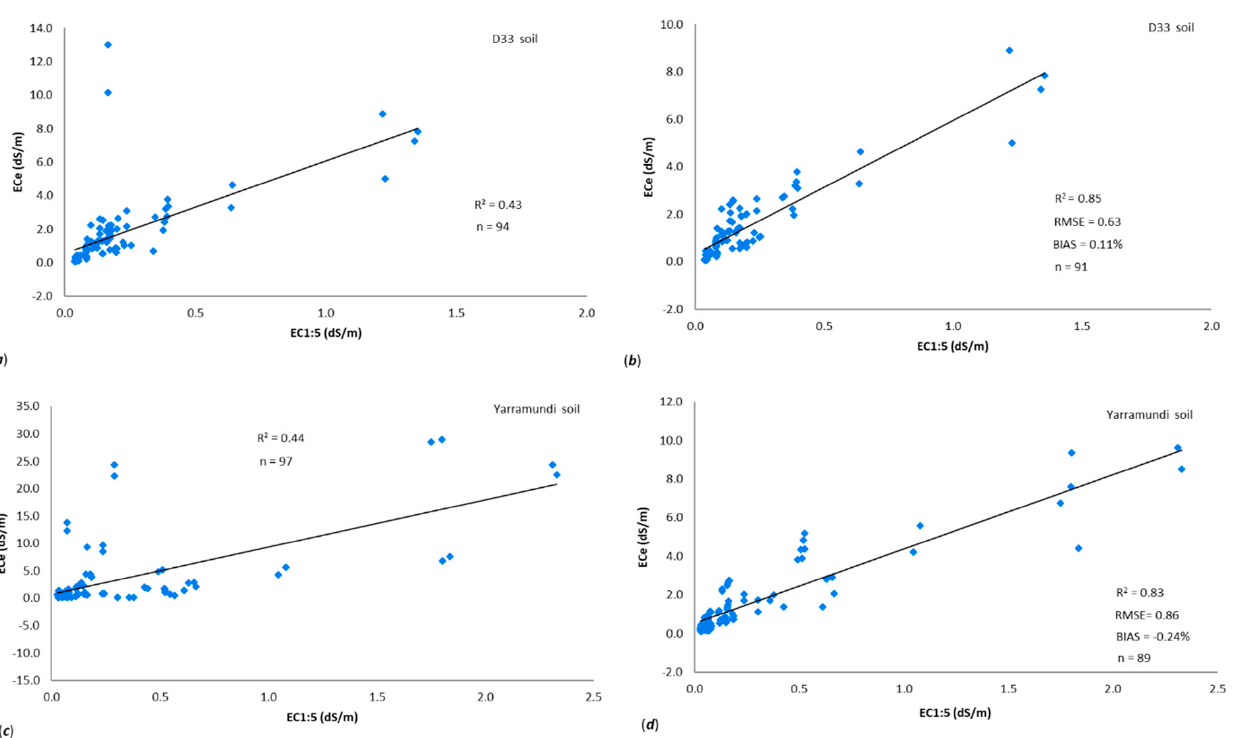
Figure 7. Relationships between EC 1:5 and EC e for soil samples collected from depths 0 to 0.3 m after 330 days of column study from ( a ) D33 soil columns for all data ( b ) D33 soil columns for EC e data ranged between 0 and <10 dS/m and EC 1:5 data ranged between 0 and <1.5 dS/m. ( c ) Yarramundi soil columns for all data ( d ) Yarramundi soil columns for EC e data ranged between 0 and <10 dS/m and EC 1:5 data ranged between 0 and <2.5 dS/m. Table 3. Relationships for predicting ECe from measured values of EC 1:5 proposed by some research ‐ ers. ECe = 5.04 (EC 1:5 ) + 0.37